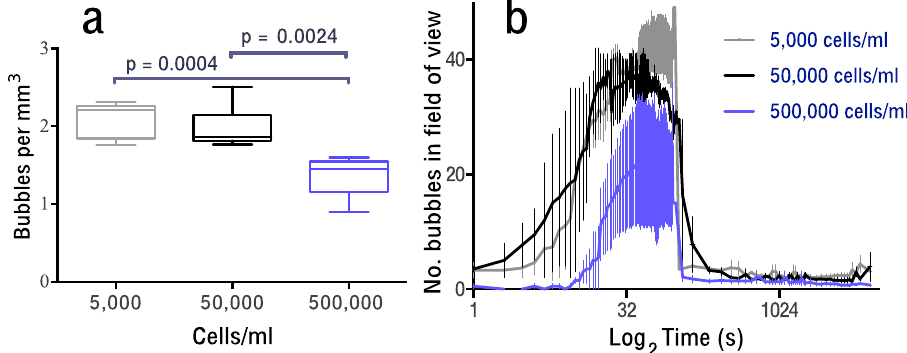
Figure 4. Nucleation of bubbles within cellular tissue phantoms containing 5,000, 50,000 or 500,000 HDF cells/ml. ( a ) The maximum number of bubbles which nucleated (median and min-max range shown), statistical significant was found between 500,000 vs. 5,000 cells/ml and (p = 0.0004) 500,000 vs. 50,000 cells/ml (p = 0.0023) as assessed by one way ANOVA (Tukey’s multiple comparison correction), ( b ) the variation in the number of bubbles in the field of view over time (N = 3 tissue phantoms per cell density).